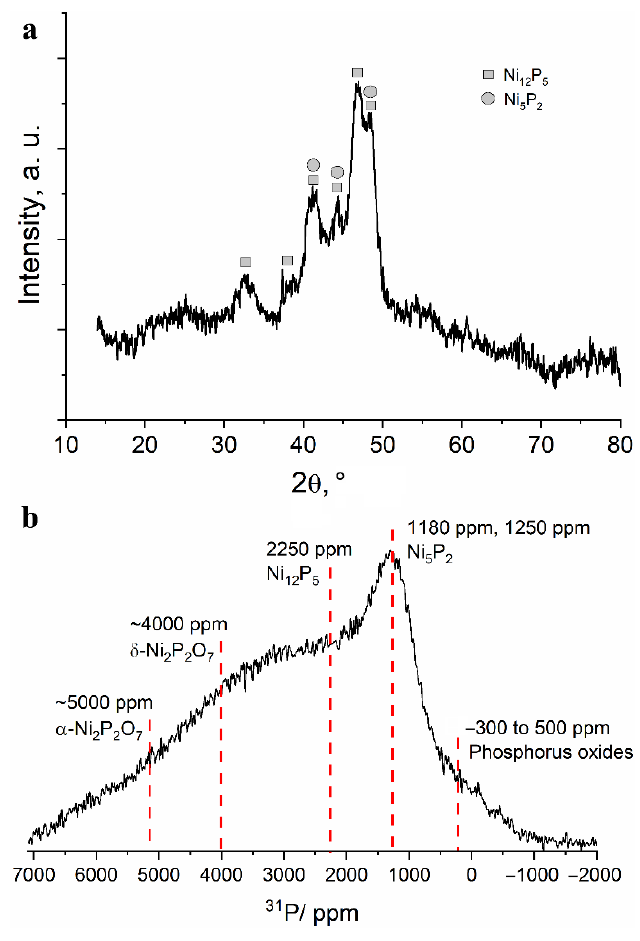
Figure 6. ( a ) Fragment of an X-ray diffraction pattern and ( b ) 13 kHz MAS 31 P NMR spectrum obtained for the separated fine powder after heating at 500 °C in vacuum.